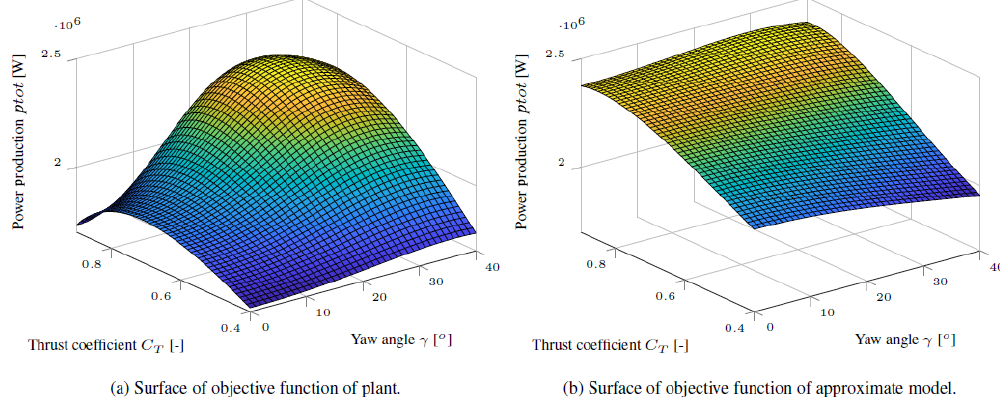
Figure 3. The power production of the plant and approximate model in dependency on the control inputs of the upwind turbine.